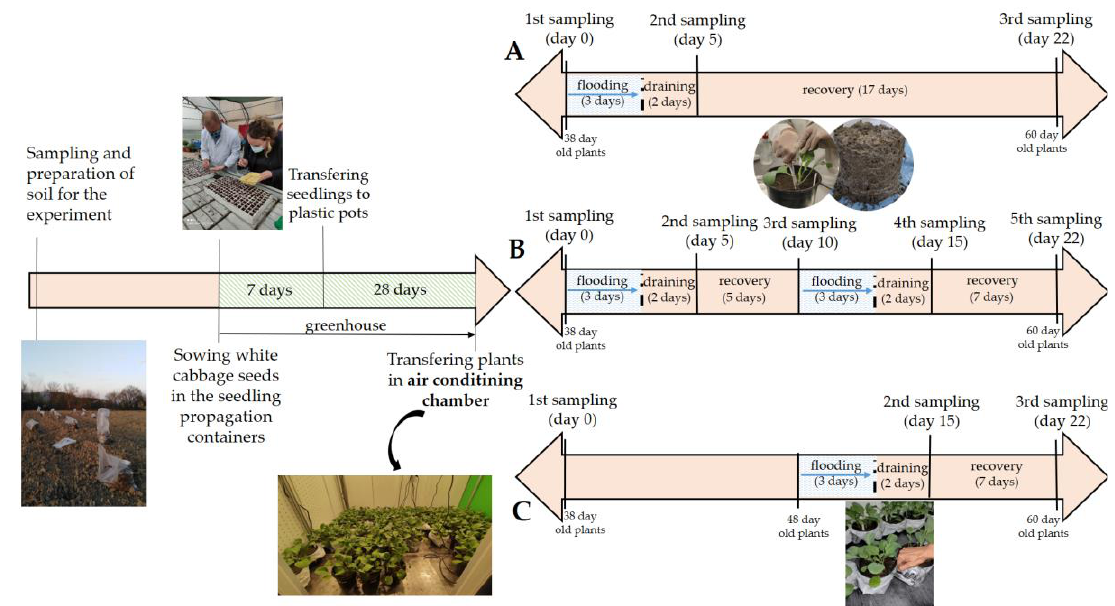
Figure 1. Experimental set-up with three different waterlogging regime treatments: Treatment 1: set-up in which the white cabbage plants were waterlogged once at the early growth stage ( A ). Treatment 2: set-up in which the white cabbage plants were waterlogged twice ( B ). Treatment 3: set-up in which the white cabbage plants were waterlogged once at the later growth stage ( C ). The experiment was conducted under controlled conditions in the growth chamber.